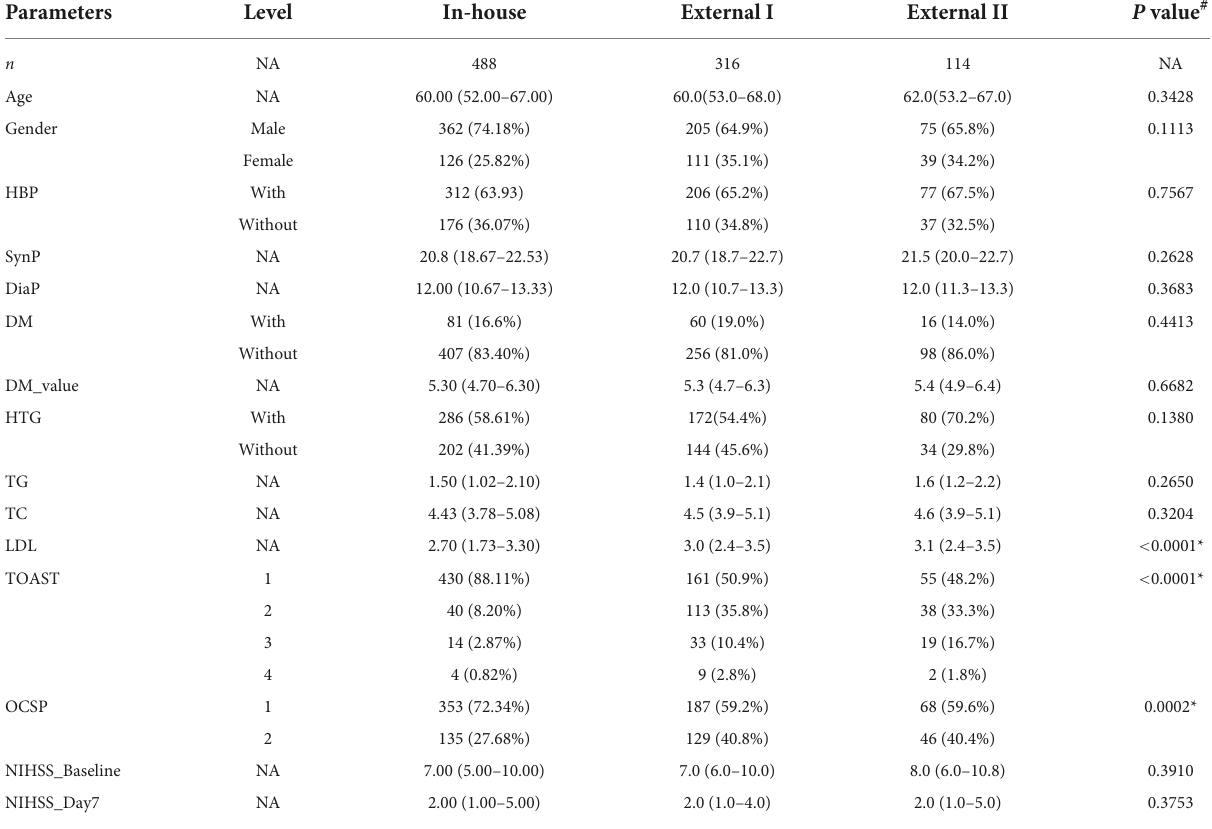
TABLE 3 Clinical characteristics of patients with different datasets.